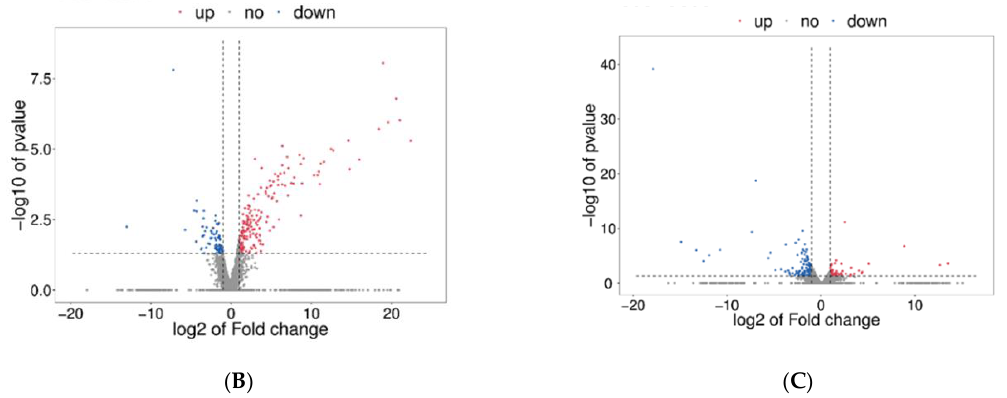
Figure 3. Statistics of DEG in FWG vs. BWG, FWK vs. BWK groups. ( A ) Venn diagram of DEGs in FWG vs. BWG group, FWK vs. BWK group, ( B ) upregulated and downregulated DEGs in FWG vs. BWG group, ( C ) upregulated and downregulated DEGs in FWK vs. BWK group.